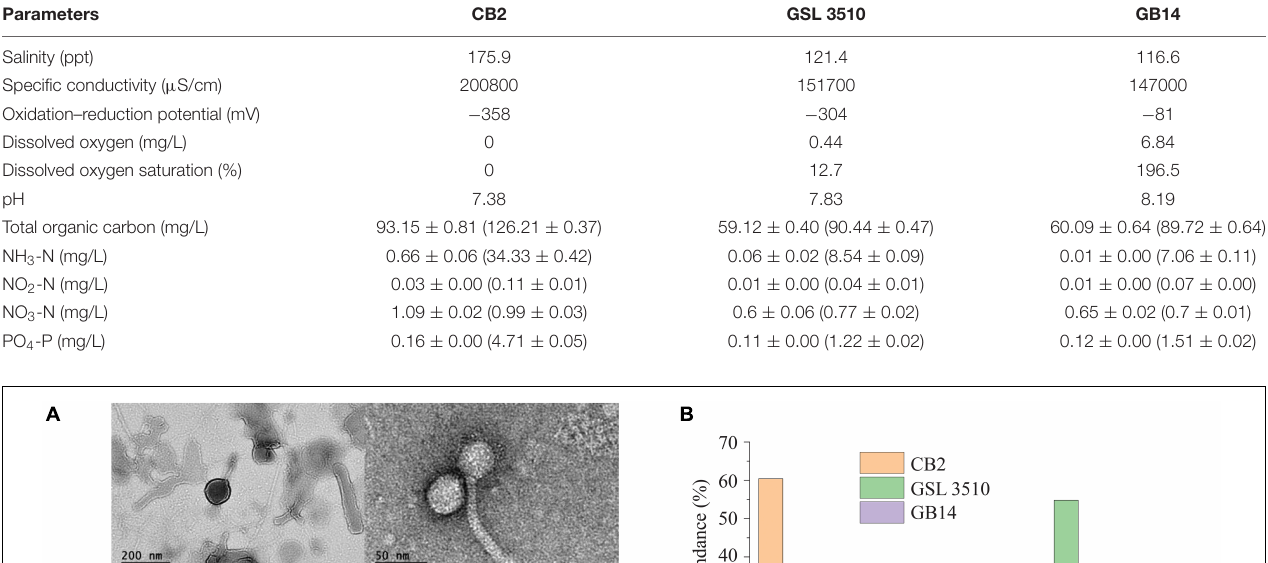
TABLE 1 | Environmental properties determined for sediments, pore water (included within parentheses), and lake water sampled on 10th August 2017 from three locations in the Great Salt Lake. Parameters